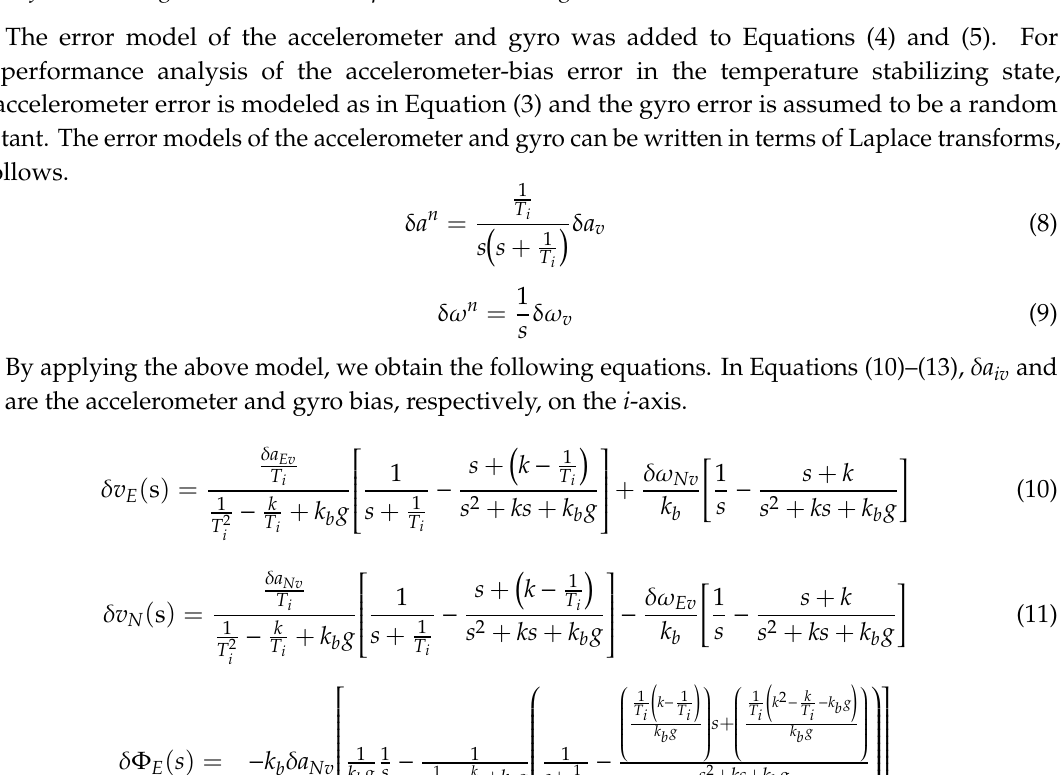
Figure 4. Error model of the self-alignment loop. While E(N)-axis velocity error δ v E ( δ v N ) induces N(E)-axis attitude error δ Φ N ( δ Φ E ), vertical attitude is not related to horizontal velocity errors.